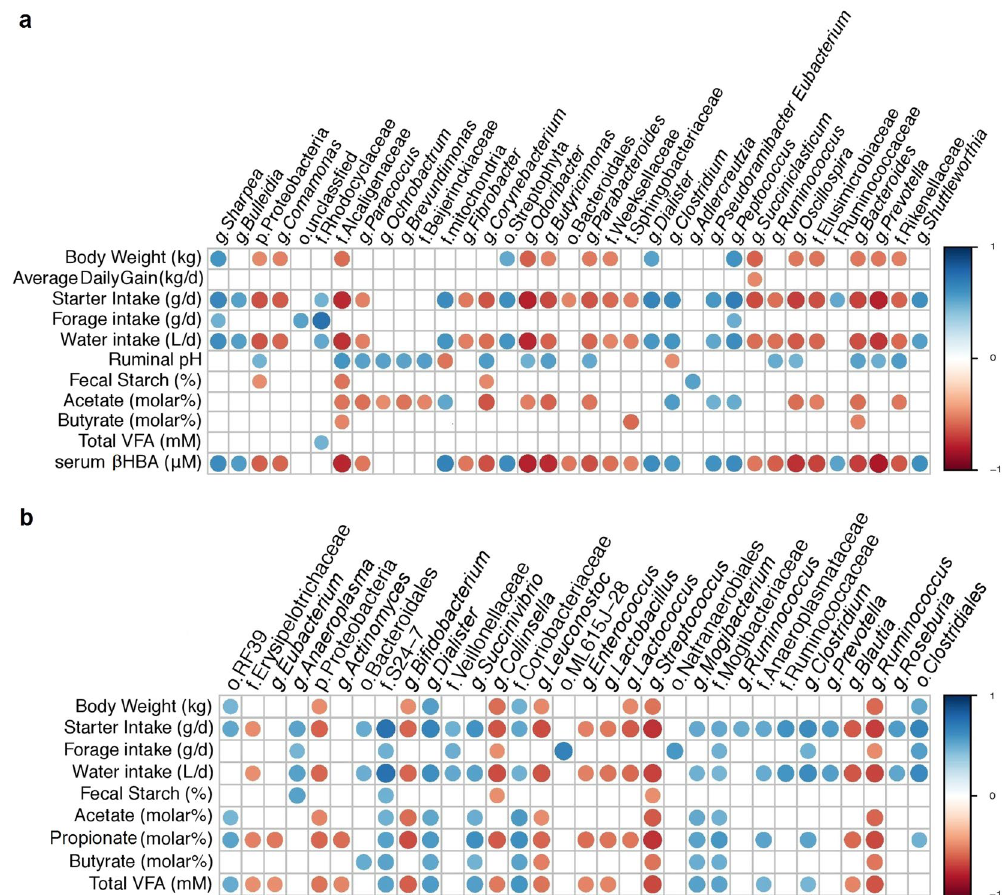
Figure 5. Correlations between production variables and relative taxa abundance. Spearman non-parametric rank correlation matrix of the dominant bacterial genera across ( a ) rumen and ( b ) faecal samples. The genera were included in the matrix if they were in at least 50% of calves and represented at least 0.1% of the bacterial community in at least one calf. All correlations presented were statistically significant (P < 0.05), with strong correlations indicated by large circles and weaker correlations indicated by small circles. The scale colours denote whether the correlation is positive (closer to 1, blue circles) or negative (closer to − 1, red circles) between the taxa and production variables. The OTU count data was subjected to variance stabilising transformation then pairwise Spearman correlations between bacterial genus and biological parameters at corresponding ages were analysed. P-values were adjusted for multiple